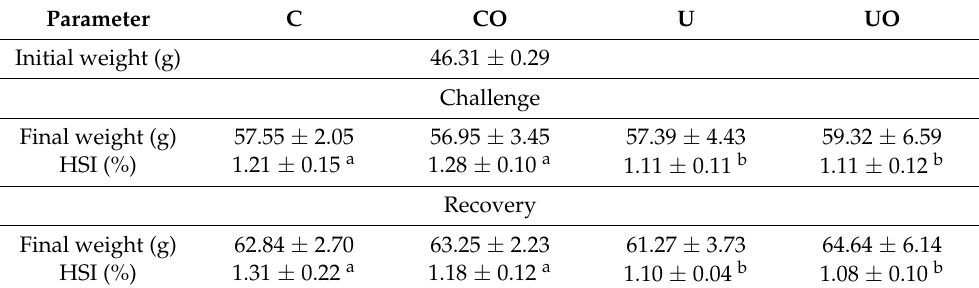
Table 7. Experiment 3. Biometric parameters obtained after the two phases of the experiment. Values presented as mean ± SD. Values in a column not sharing the same letter differ significantly with p <